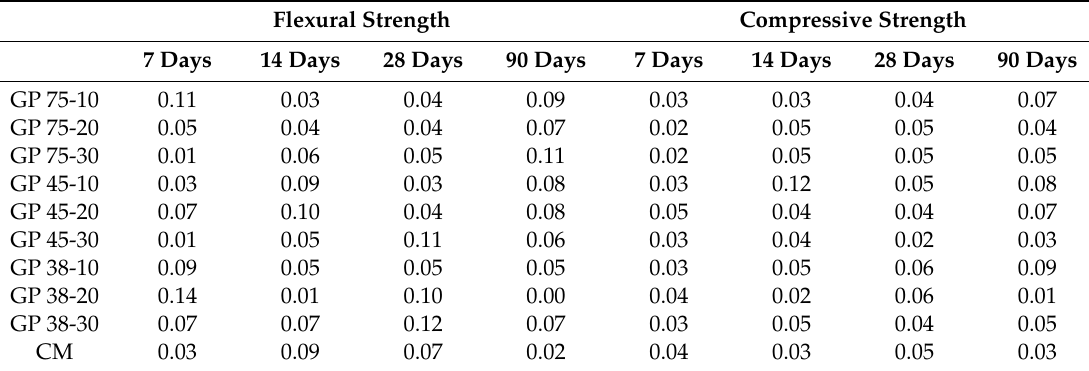
Table 3. Variation coe ffi cients of mechanical properties at di ff erent ages.